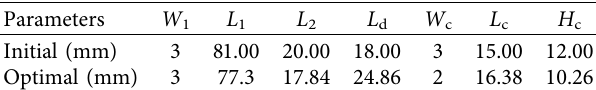
Table 2: Parameters of UHF-RFID tag antenna.